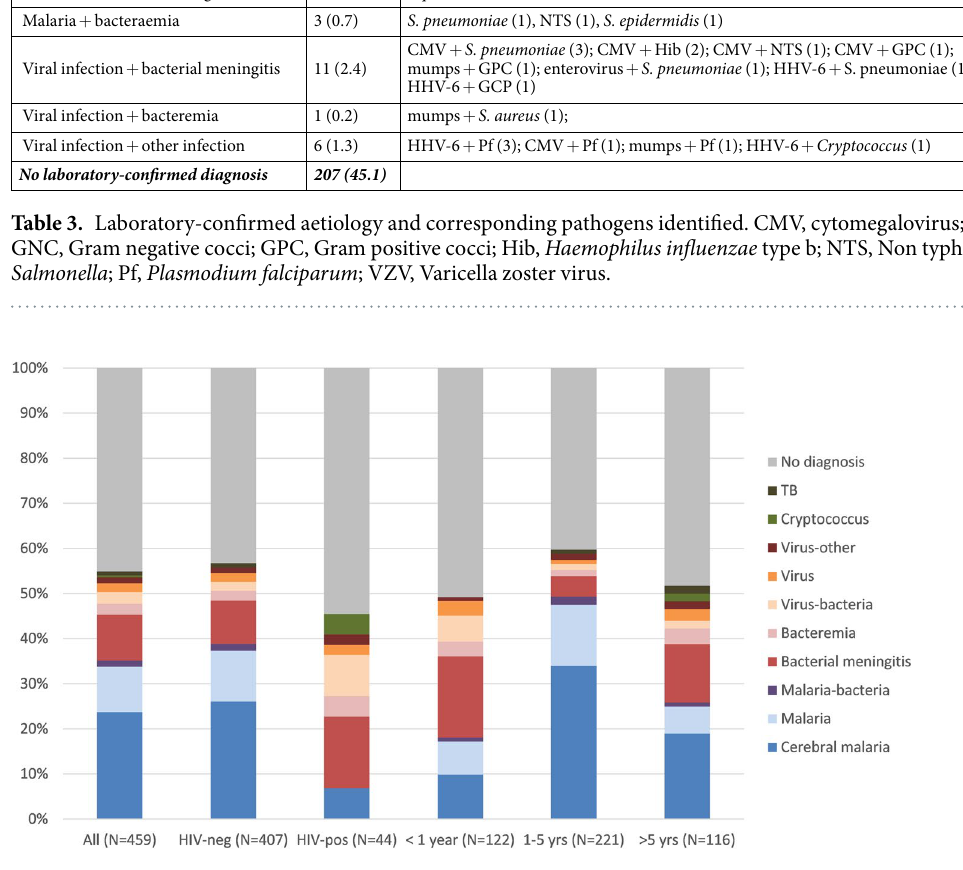
Figure 2. Laboratory-confirmed etiology of CNS infections by HIV status and age group: all children (A, N = 459), HIV-positive (B, N = 44) HIV-negative (C, N = 415), age below one year (D, N = 122), one to 5 years (E, N = 221) and above 5 years (F, N = 116). HIV-positive include all patients positive for HIV by serology, including those less than 18 months of age